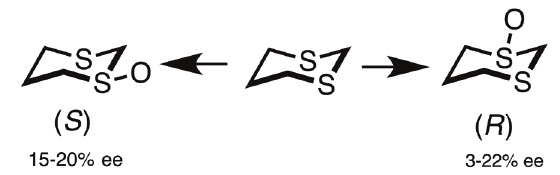
Figure 7 - Oxidation of 1,3-dithian in the presence of different Oxidation of the alkyl-aryl sulfides by Corynebacterium equi IFO 3730 (Ohta et al. 1985). Substrate SR 2